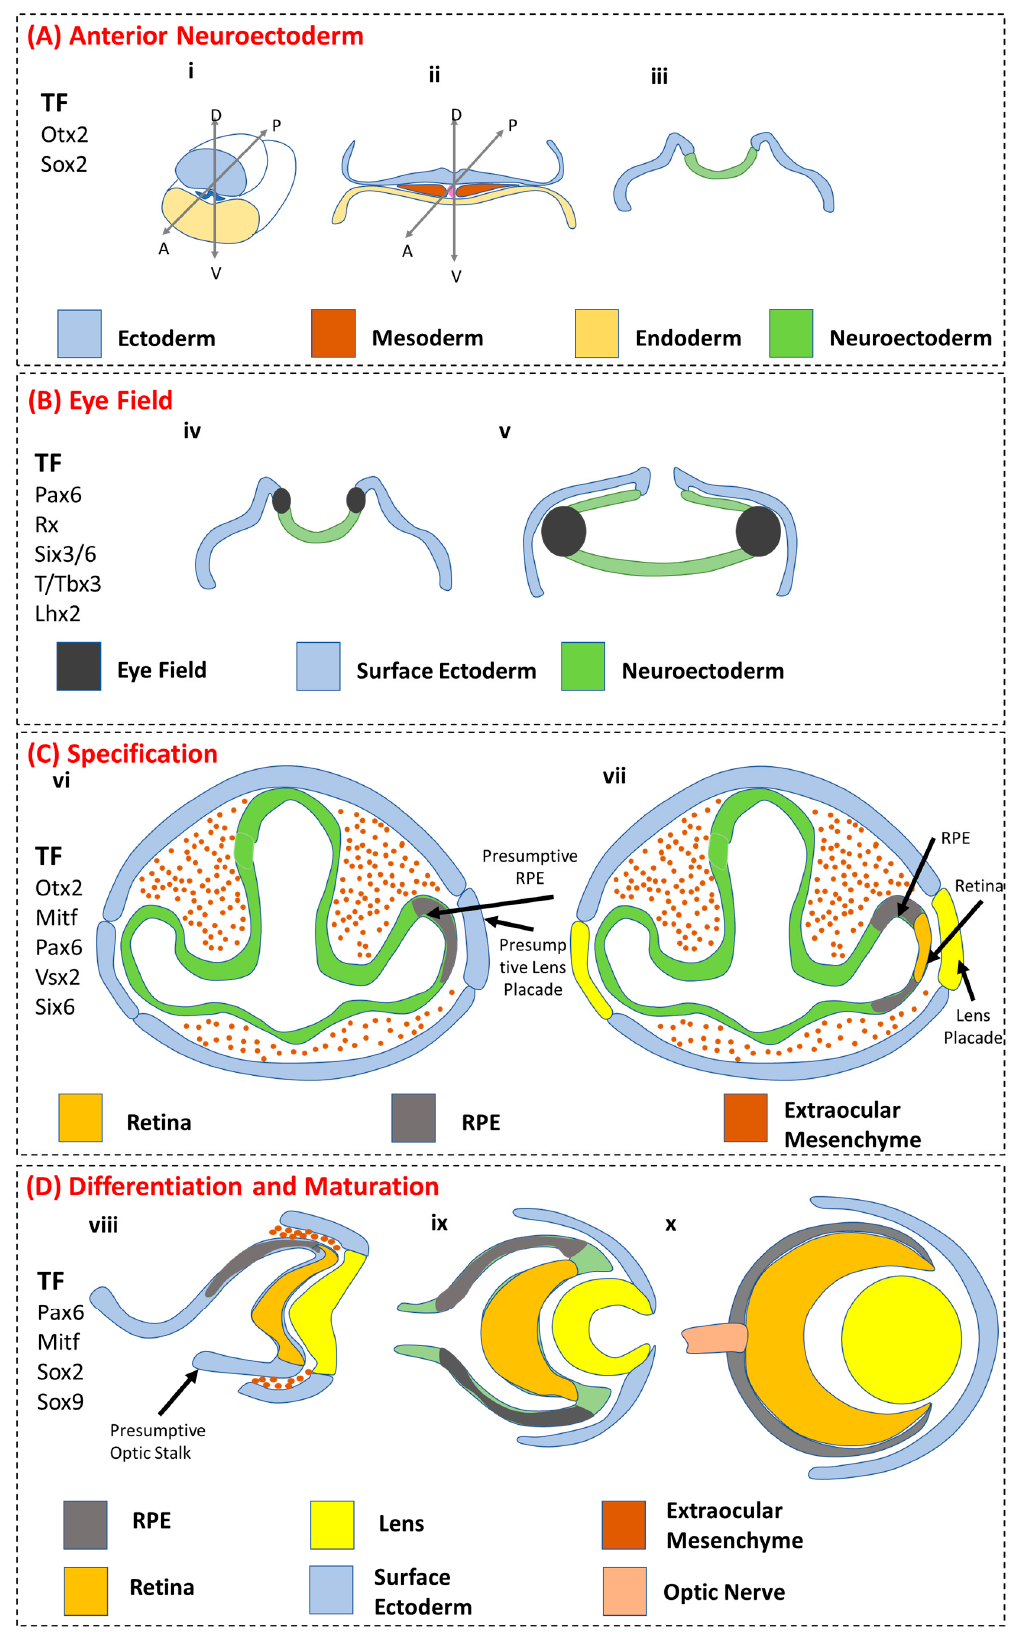
Figure 2. Schematic representation of the RPE origin and developmental progression. ( A ) Anterior neuroectoderm formation: ( Ai ) gastrulation leading to the formation of ( Aii ) three germ layers, i.e.,